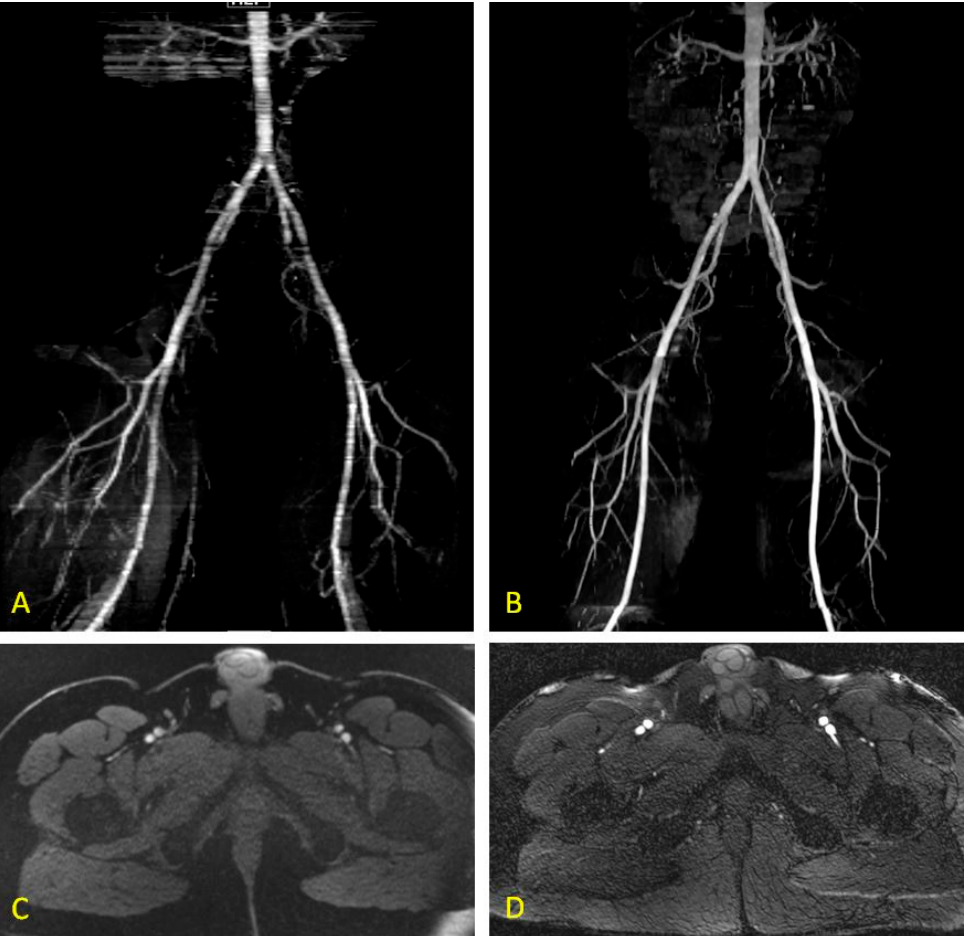
Figure 2. Time of flight (TOF) and QISS bilateral lower extremity MRA in the same patient. Coronal TOF MRA ( A ) and Coronal QISS MRA ( B ) of the pelvic arteries and lower extremities. Note the fine detail and improved signal throughout the distal aorta, iliac, and femoral arteries. Corresponding axial TOF MRA ( C ) and corresponding axial QISS MRA ( D ) at the level of common femoral bifurcation.